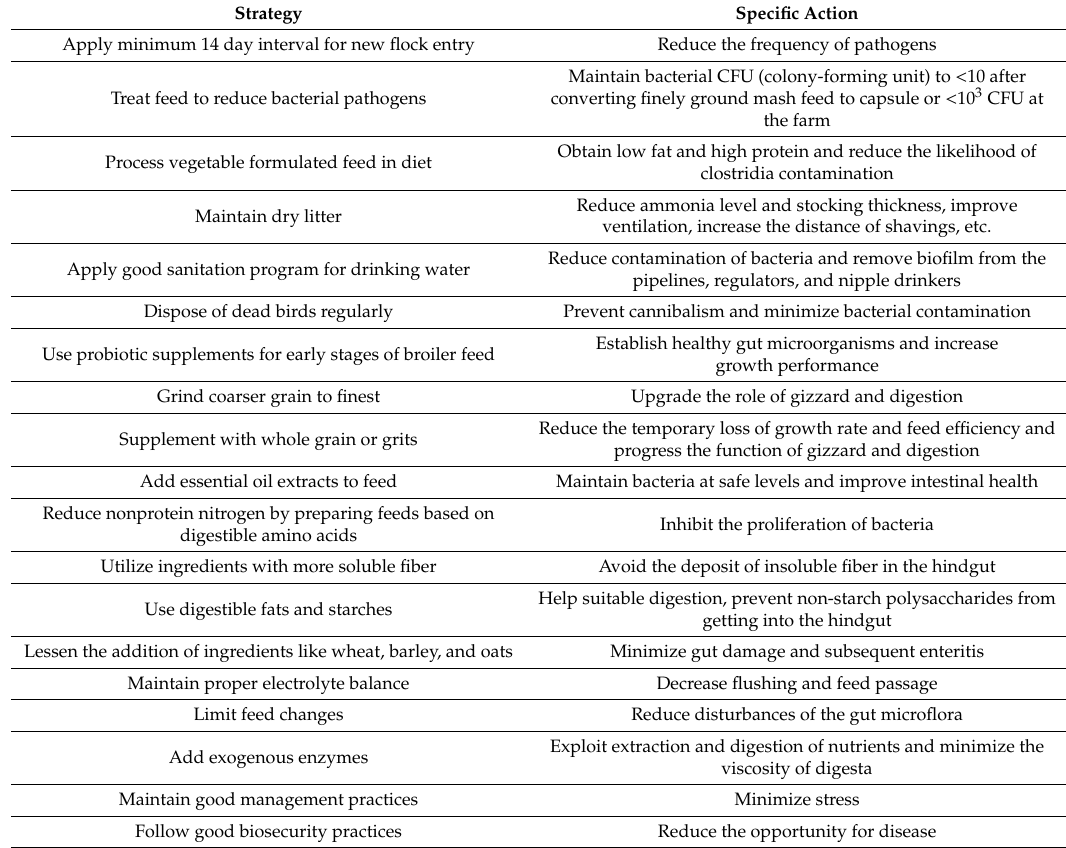
Table 1. General approaches for the production of antibiotic-free